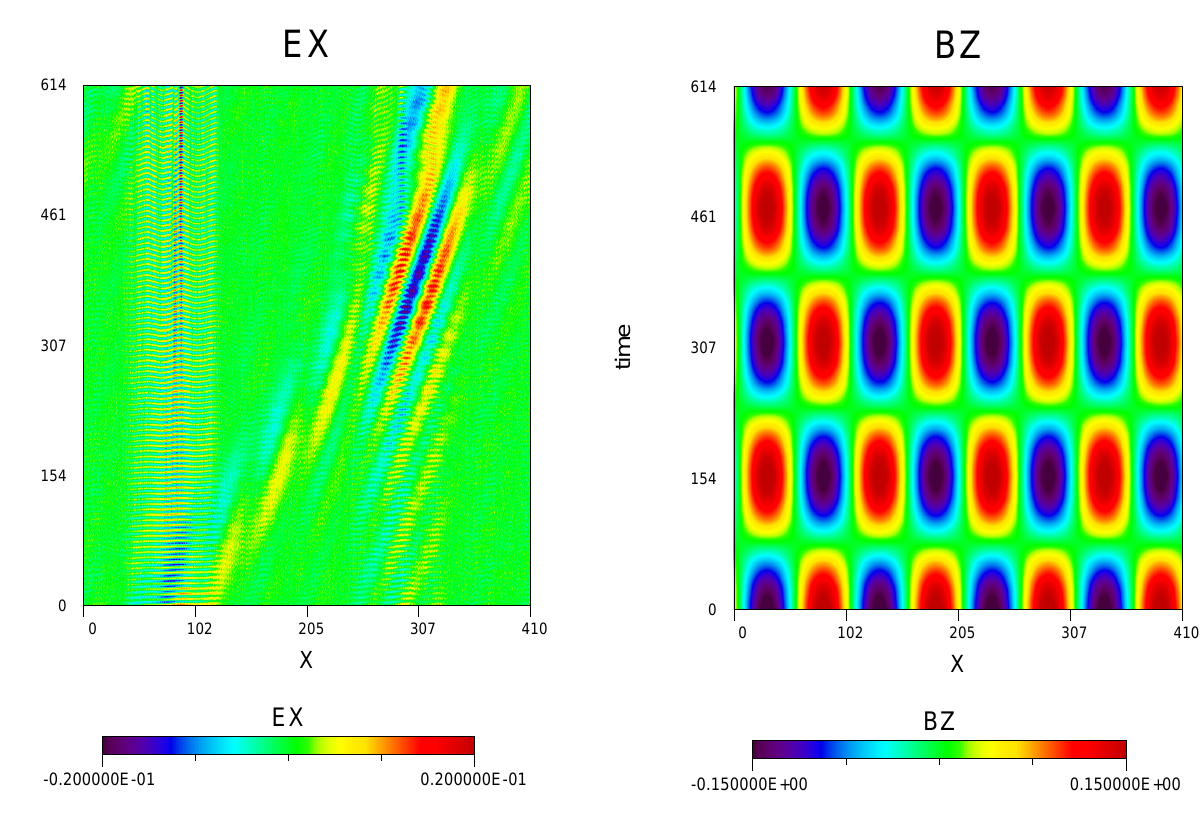
Fig. 4. AWC010 (two sinusoids). Temporal stack plot of the trans- verse magnetic field B Z (X,t)